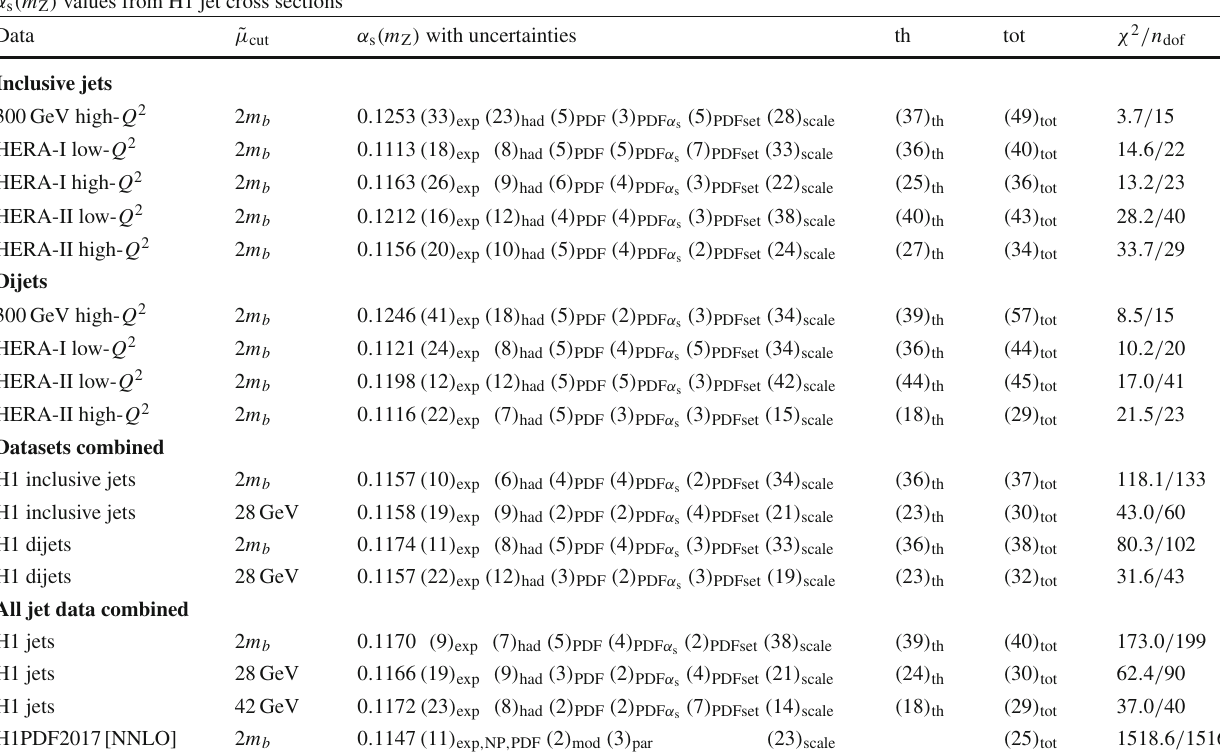
Table 4 Summary of values of α s ( m Z ) from fits to H1 jet cross sec- tion measurements using NNLO predictions. The uncertainties denote the experimental (exp), hadronisation (had), PDF, PDF α s , PDFset and scale uncertainties as described in the text. The rightmost three columns denote the quadratic sum of the theoretical uncertainties (th), the total (tot) uncertainties and the value of χ 2 / n dof of the corresponding fit. Along the vertical direction, the table data are segmented into five parts. The uppermost part summarises fits to individual inclusive jet datasets. The second part corresponds to fits of the individual dijet datasets. The α ( m ) values from H1 jet cross s Z